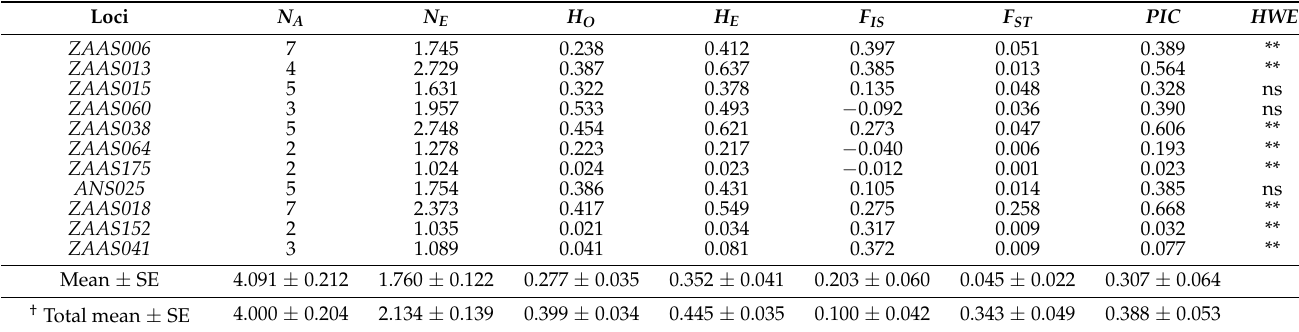
Table 4. Observed ( N A ) and effective ( N E ) number of alleles, observed ( H O ) and expected ( H E ) heterozygosity and F-statistics ( F IS and F ST ) and polymorphism information content ( PIC ) across the three Egyptian goose populations. Loci